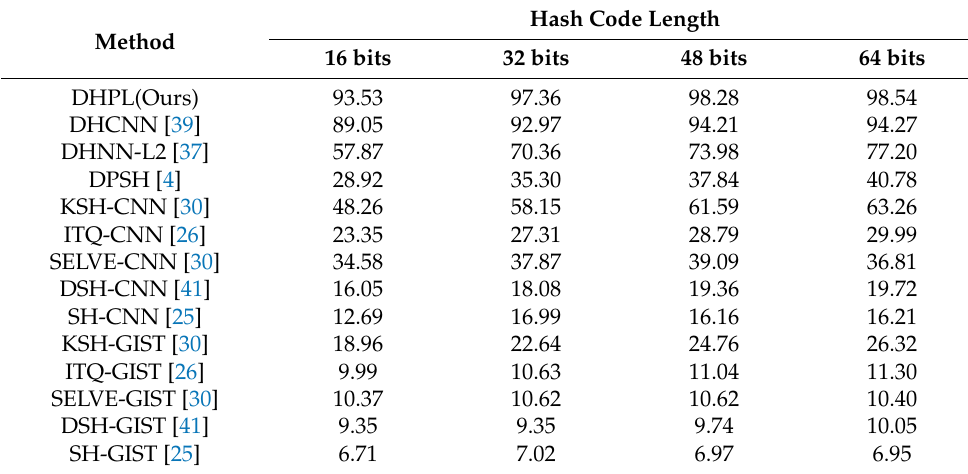
Table 3. mAP retrieval results on the AID dataset, and we give separate hash retrieval results for 16, 32, 48, 64 bits. The test set has 5000 images (each category randomly takes 50% of the images). We have thickened the best